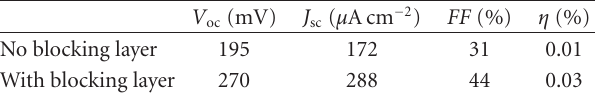
Table 2: V oc , J sc , FF , and η of DSSC with platinum as counter electrode for black rice dye solution at pH 1. Electrolyte is 26.9